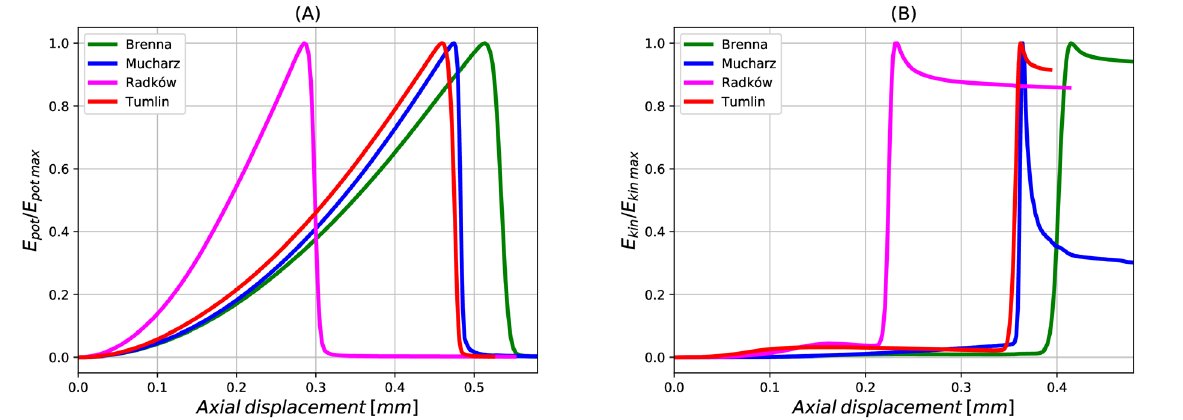
/ E and (B) scaled kinetic energy E pot pot max